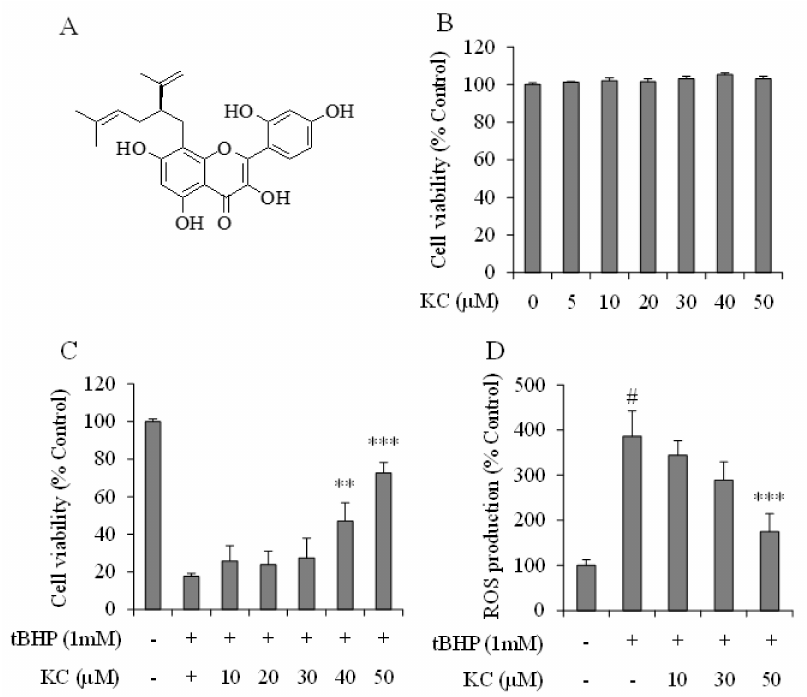
Figure 1. Effect of kushenol C on cell viability and reactive oxygen species (ROS) production in tBHP- treated HEPG2 cells. ( A ) The Chemical structure of Kushenol C (KC). ( B ) Cells were treated with different concentration of KC and cell viability was determined using EZ-Cytox reagent. ( C ) Cells were preincubated with KC at different concentrations for 1 h and then treated with tBHP for 24 h. Cell viability was determined using EZ-Cytox reagent. ( D ) Cells were preincubated with KC at different concentrations for 1 h and then treated with tBHP for 1 h and ROS production was determined as described in the Materials and Method section. Error bars represent the mean ± SD, # p < 0.001 vs. Control, ** p < 0.01, *** p < 0.001 vs. tBHP-only treated